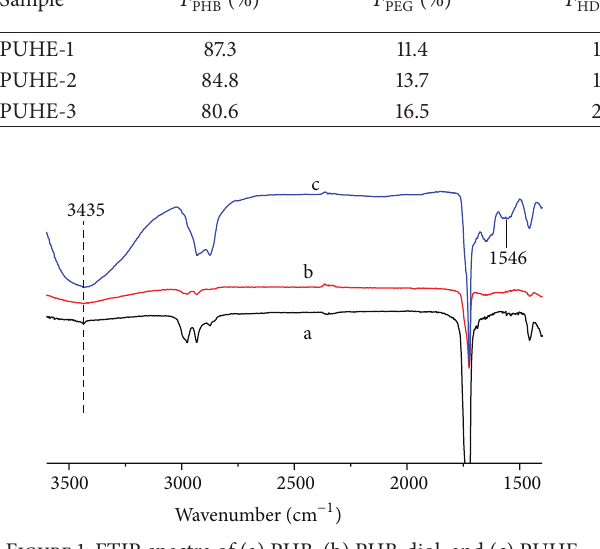
Figure 1: FTIR spectra of (a) PHB, (b) PHB-diol, and (c) PUHE.